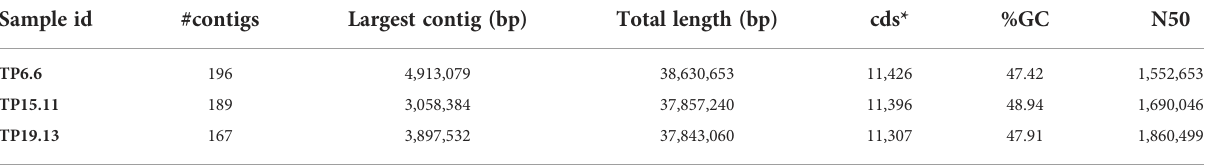
*Number of coding sequences (cds) deduced from each genome sequence through Augustus